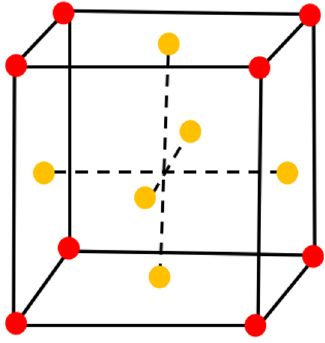
Figure 8 . The face-centred cubic